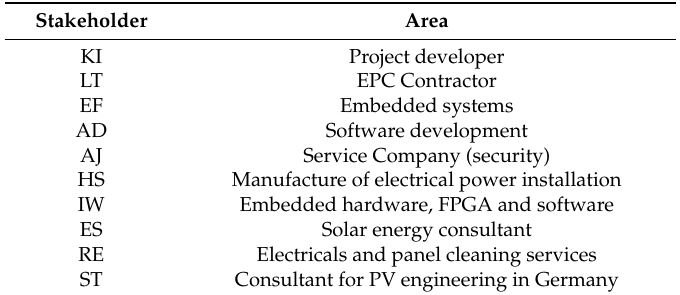
Table 4. Partial List of Stakeholders of the Charanka Plant Case